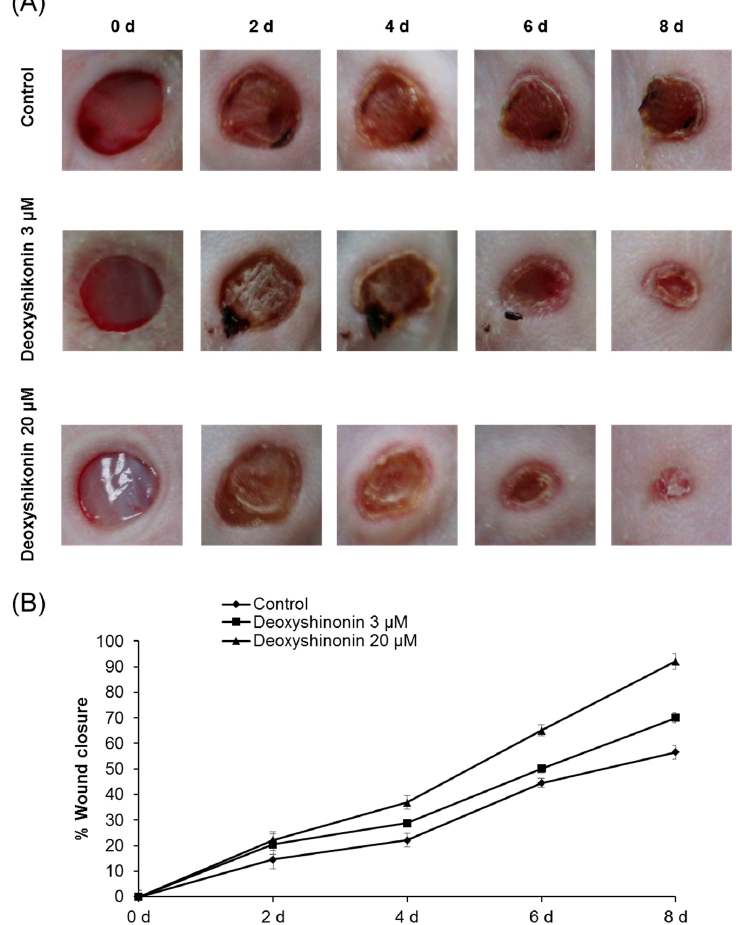
Figure 5. Effects of deoxyshikonin on wound closure rates in a diabetes mouse model. ( A ) Representative images of wounds treated with deoxyshikonin (3 and 20 µ M) or phosphate-buffered saline (PBS; control) in mice with the streptozotocin (STZ)-induced diabetes at 0, 2, 4, 6, 8, 10, and 12 days after grafting. Representative photographs of the wounds at 0, 2, 4, 6, 8, 10, and 12 d after grafting. ( B ) Wound closure rates relative to the rate achieved with PBS treatment. Wound closure rates were calculated as the ratio of the open wound area at each time point, divided by the total wound area at the corresponding time point. Data are expressed as means ± SEM. Similar results were obtained from three independent experiments.